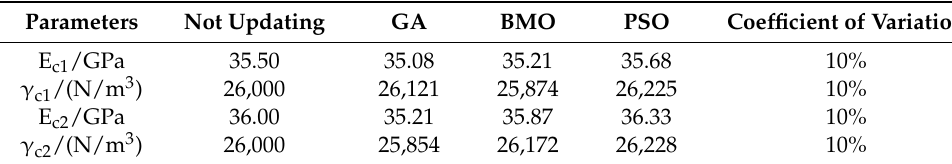
Table 4. The updating parameters of finite element